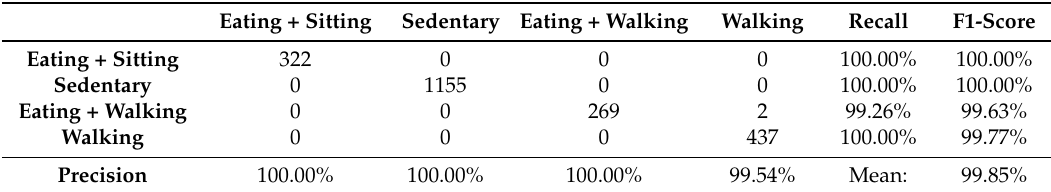
Table 4. Confusion Matrix for multi-class classification when two stage classification is used. Precision, Recall and F1-score are also listed for each class/categories of activities.